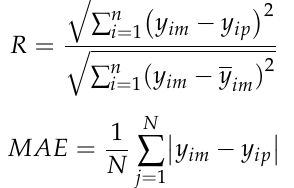
Figure 7. Predicted PPV values of the SVM models with different Kernels.